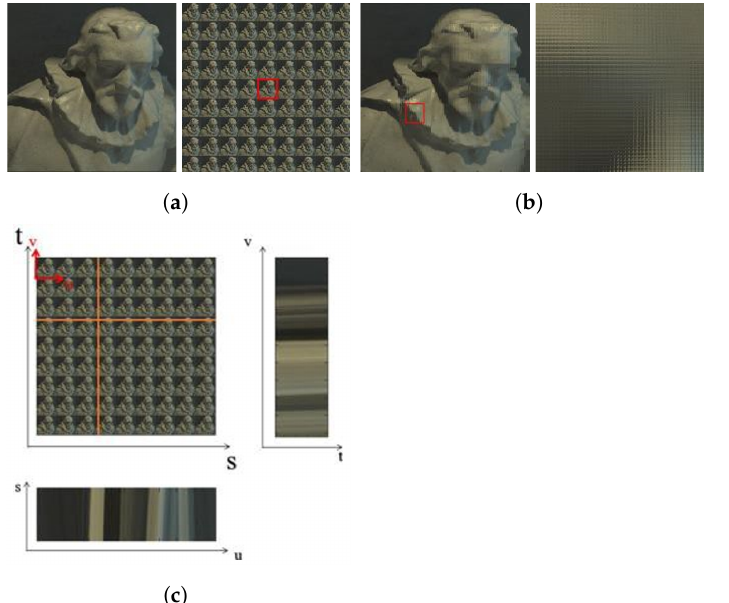
Figure 4. The three representations of the two-plane light field. ( a ) The sub-aperture images or the pinhole view. ( b ) The sub-view for the light field. ( c ) Epipolar-plane image, which is obtained by fixing both spatial and angular co-ordinates